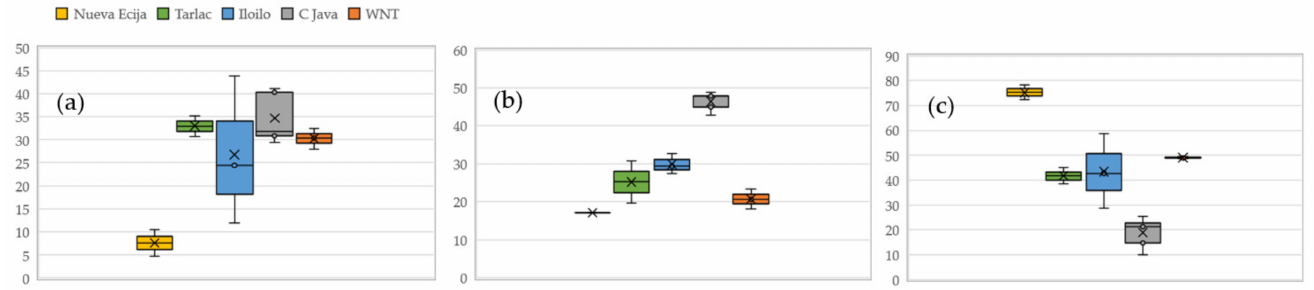
Figure 2. Soil texture of the target sites: ( a ) sand, ( b ) silt and ( c ) clay contents. The x-axis shows the provinces in each